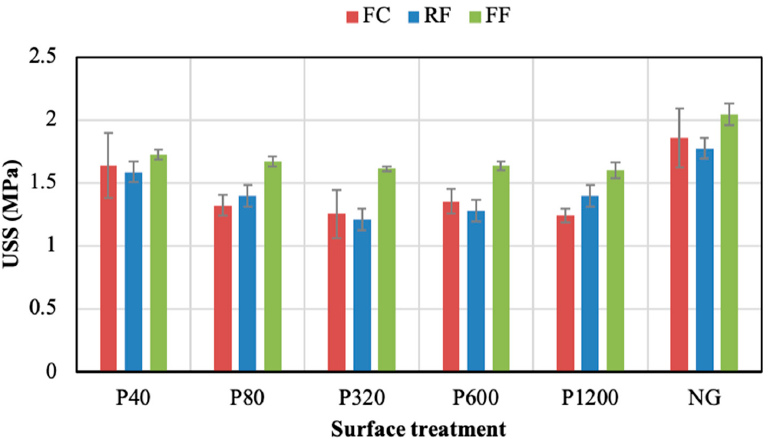
Figure 9. Ultimate shear strength (USS) of adhesive joints under different surface with adhesion promoter.